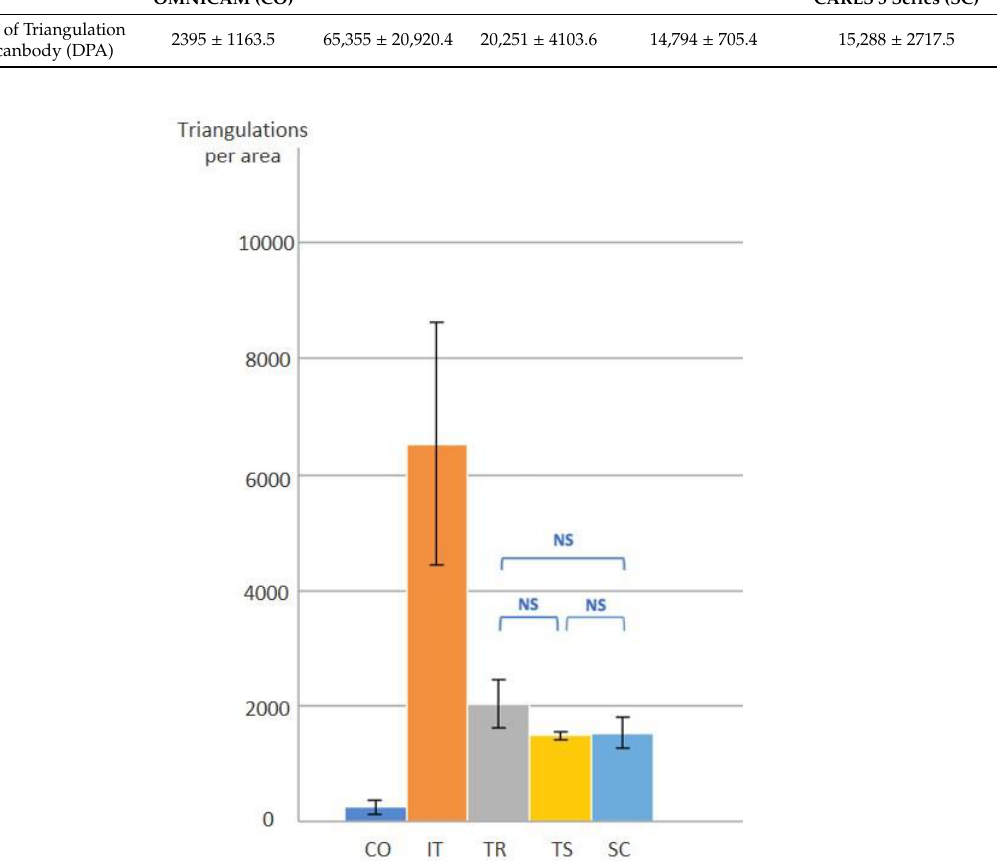
Figure 6. Triangulation points on the top surface area of the scanbody #5. NS: p <